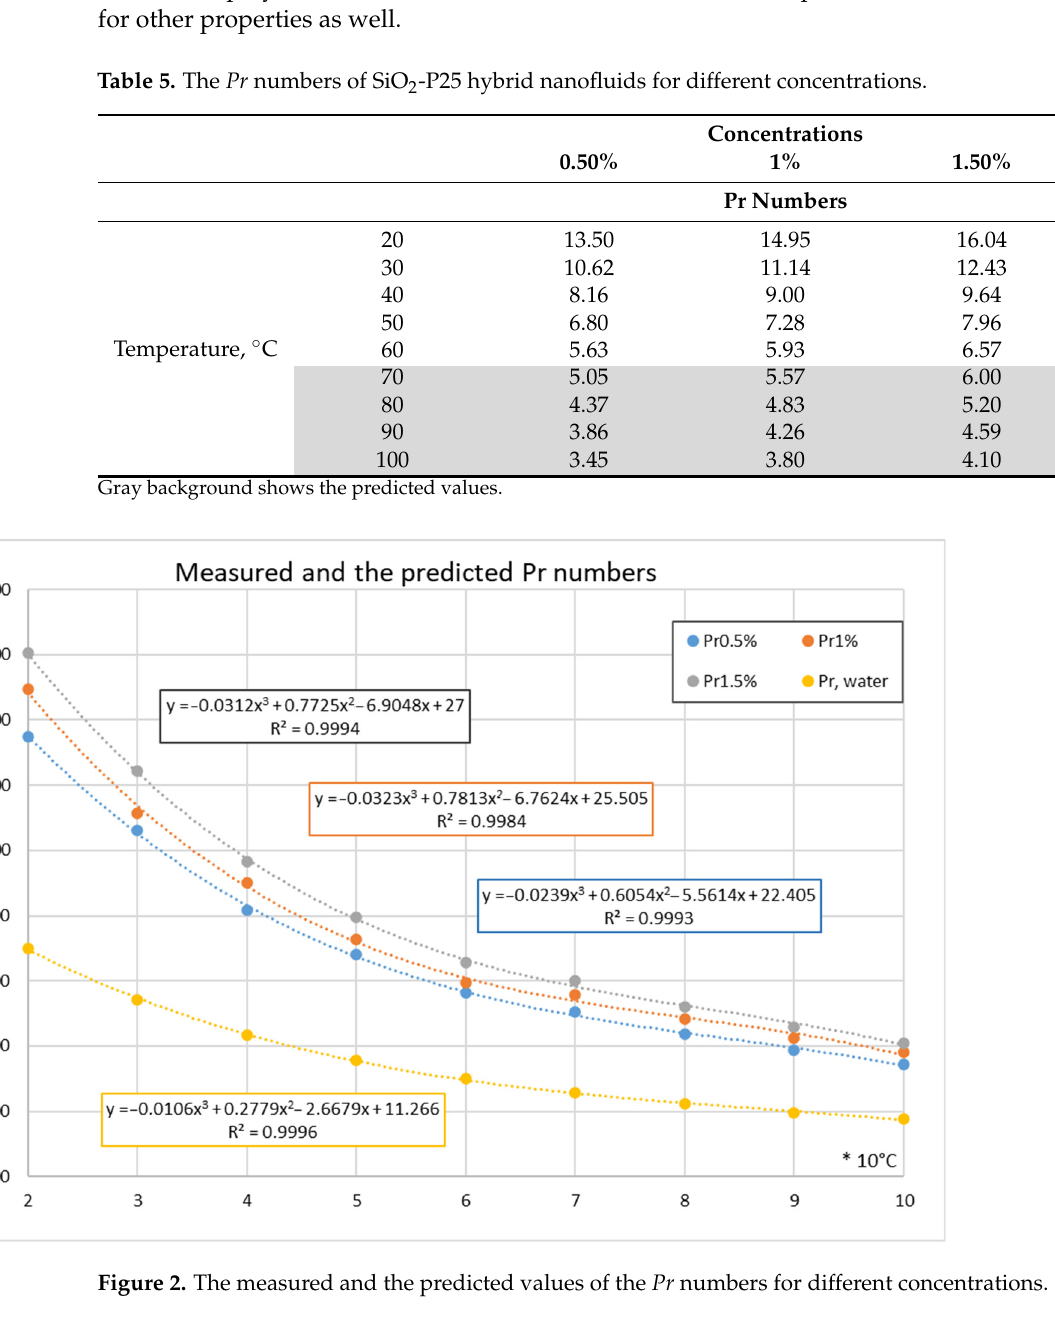
Figure 3. Velocity profiles for constant and variable viscosity [25], reprinted from Springer Nature open access article under the terms of the Creative Commons CC-BY license. Since the mean fluid temperature plays a central role in the HT coefficient calculation, Equation (3) shows its calculation. 𝑇 (cid:3040)(cid:3032)(cid:3028)(cid:3041),(cid:3033) = (cid:1516) (cid:3050)((cid:3045))∙(cid:3096)((cid:3021)((cid:3045)))∙(cid:3004) (cid:3291) ((cid:3021)((cid:3045)))∙(cid:3021)((cid:3045))∙(cid:3031)(cid:3045) (cid:3267) (cid:3116) (cid:1516) (cid:3050)((cid:3045))∙(cid:3096)((cid:3021)((cid:3045)))∙(cid:3004) (cid:3291) ((cid:3021)((cid:3045)))∙(cid:3031)(cid:3045) (cid:3267) (cid:3116)